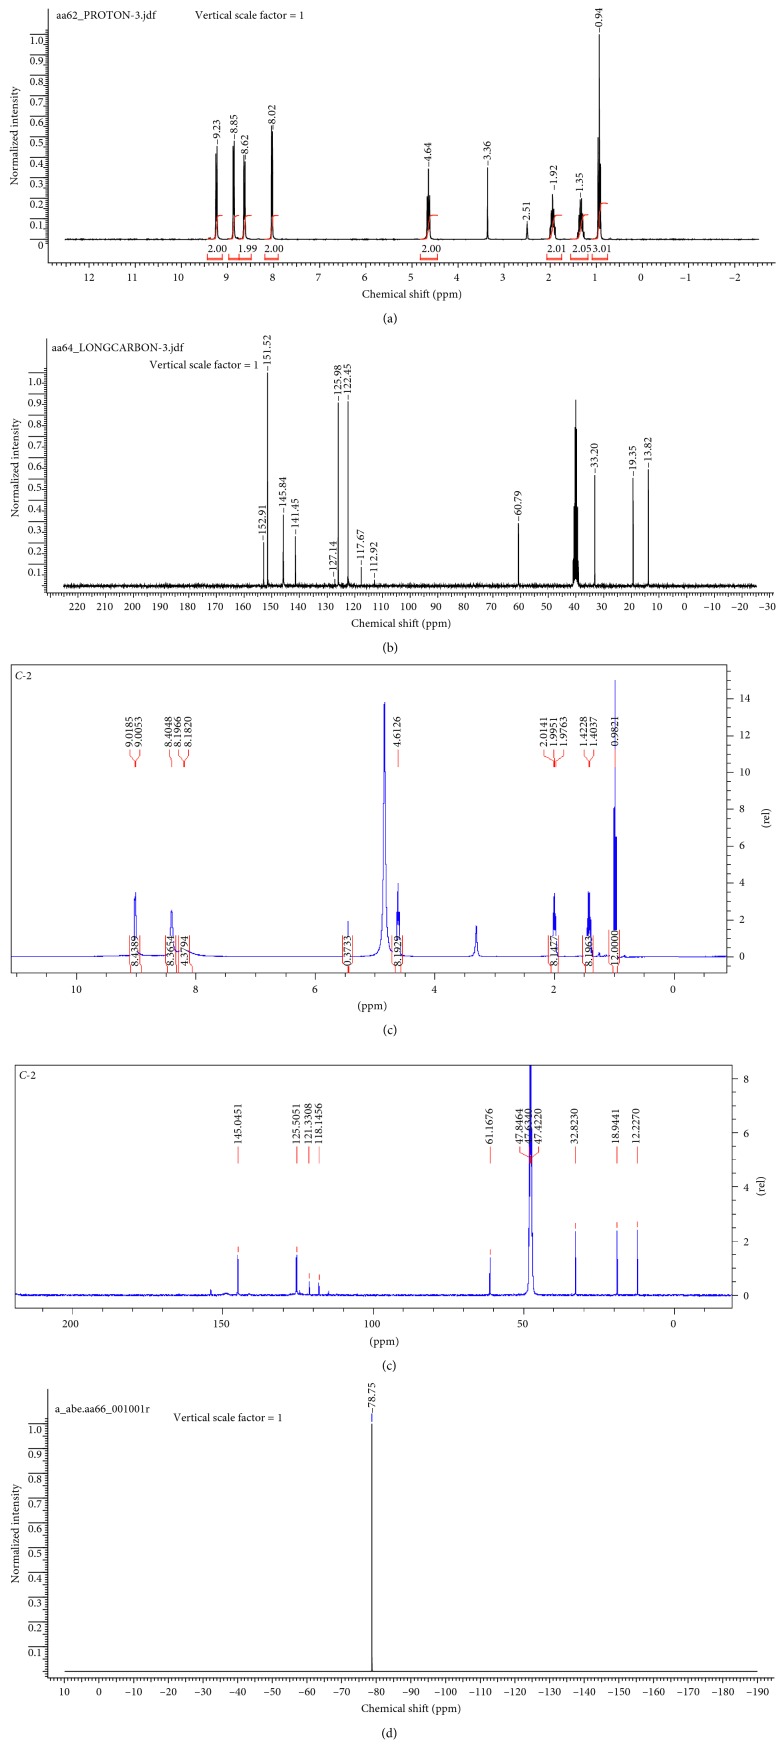
(a) 1H NMR of the ionic liquid; (b) 13C NMR of the ionic liquid; (c) 1H NMR of the complex; (d) 13C NMR of the complex; (e) 19F NMR of the ligand.